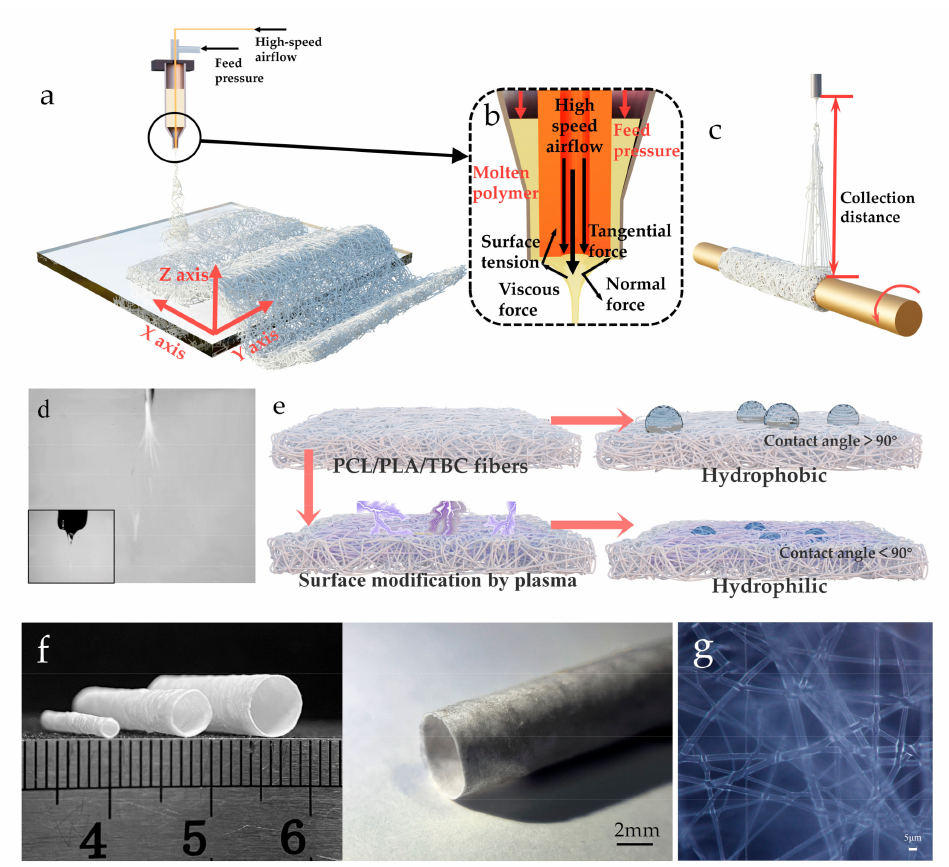
Figure 1. ( a ) Schematic diagram of the 3D printing fiber process. ( b ) Schematic diagram of fiber printing. ( c ) Schematic diagram of the tubular microfiber scaffold printing process. ( d ) The state of the jet stream taken by a high-speed camera. ( e ) Schematic diagram of plasma fiber surface modification process. ( f ) Diagram of finished tubular microfiber scaffolds with different structures. ( g ) Microscopic morphology of the